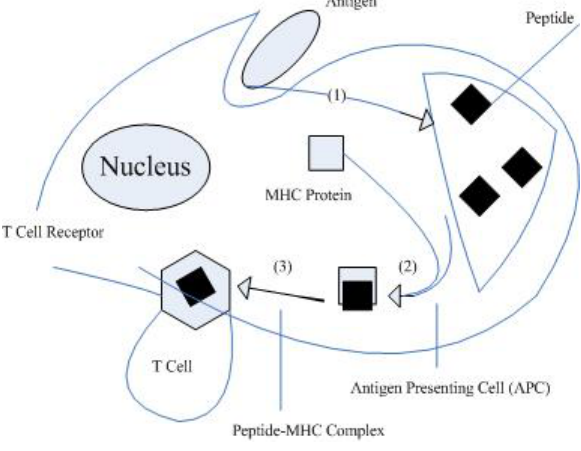
Figure 1. Processing and presentation of antigen An antibody recognizes and eliminates only a specific type of antigens. The key portion of the antigen recognized by the antibody is called epitope, an antigen determinant, as shown in Figure 2. The paratope is the portion of the antibody that corresponds to a certain kind of antigens. When an antibody merges an antigen via the epitope and paratope, it can attack this antigen [3].